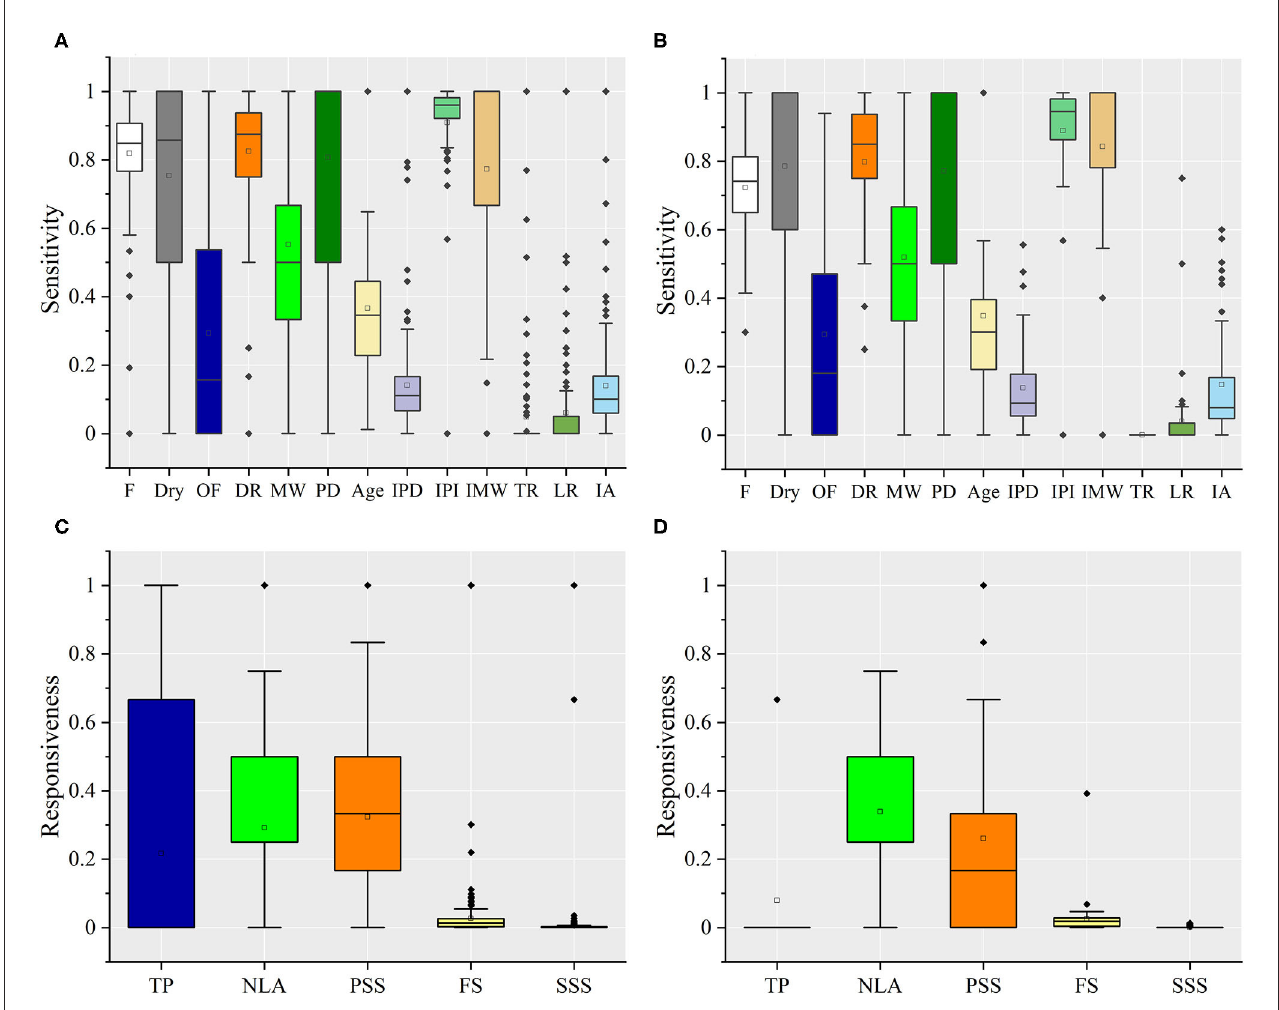
FIGURE5 Differences in subdimensions of farm households in core and periphery areas. (A, B) The sensitivity indicators for livelihoods in the core and peripheral areas, respectively; (C, D) indicators of the responsiveness of the core and peripheral areas, respectively. The abbreviations all correspond to the interpretation of the indicators in the indicator system in Table 1.